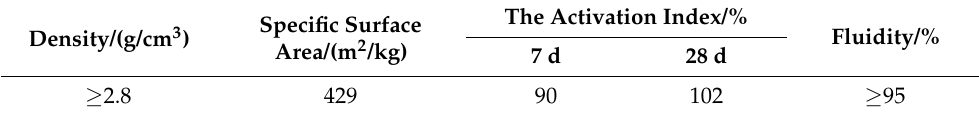
Table 4. Performance index of polycarboxylic acid high-efficiency compound